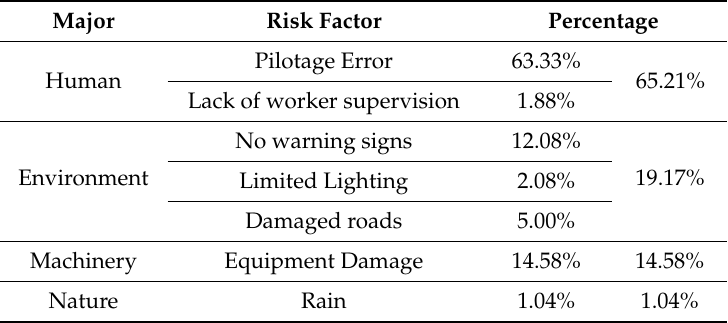
Table 10. Common causes of tra ffi c